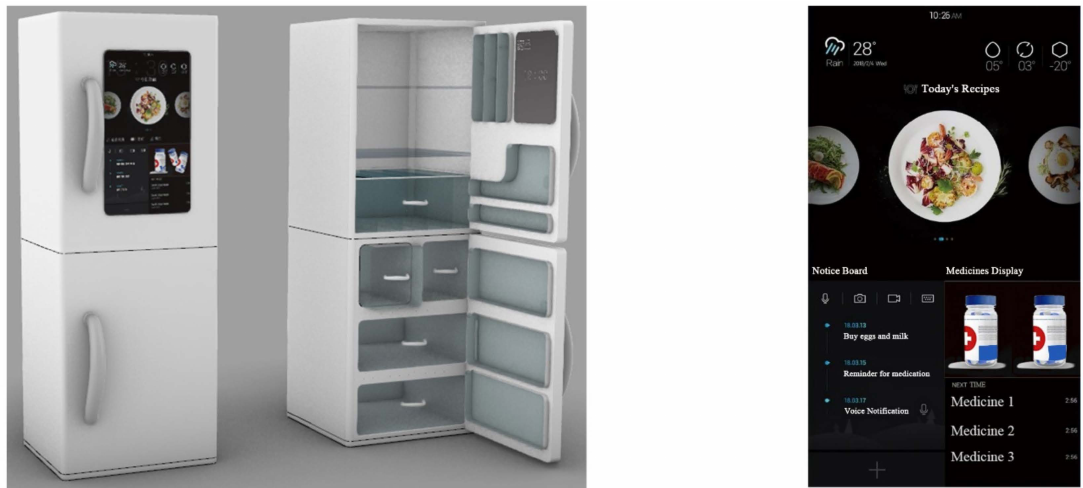
Figure 6. Scheme (C): Product and interaction interface.